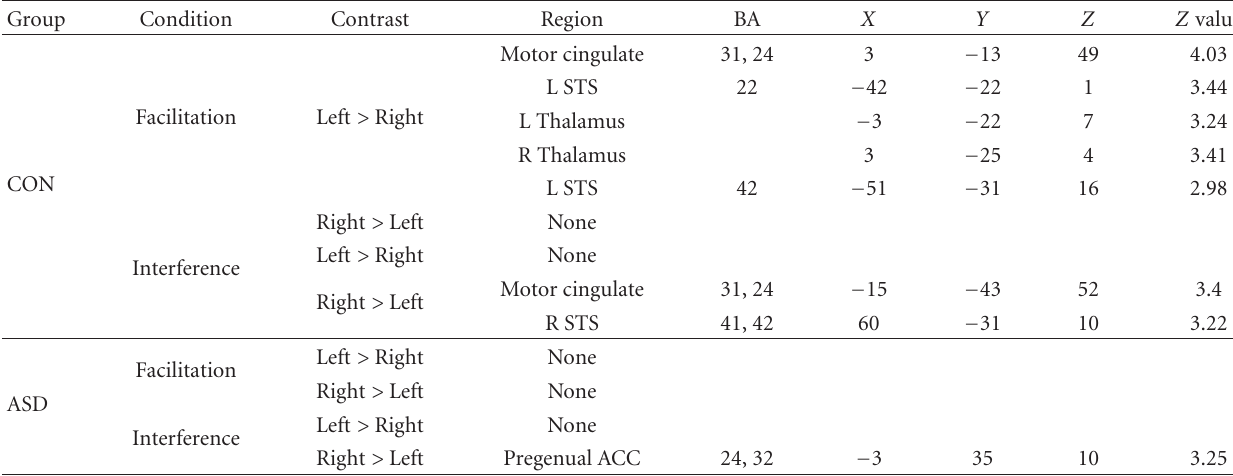
Table 3: Regions showing di ff erences between right and left amygdala connectivity in control (CON) and ASD children during facilitation (Congruent > Neutral) and interference (Incongruent > Congruent) from eye-gaze ( P < 0 . 05 Monte Carlo corrected).